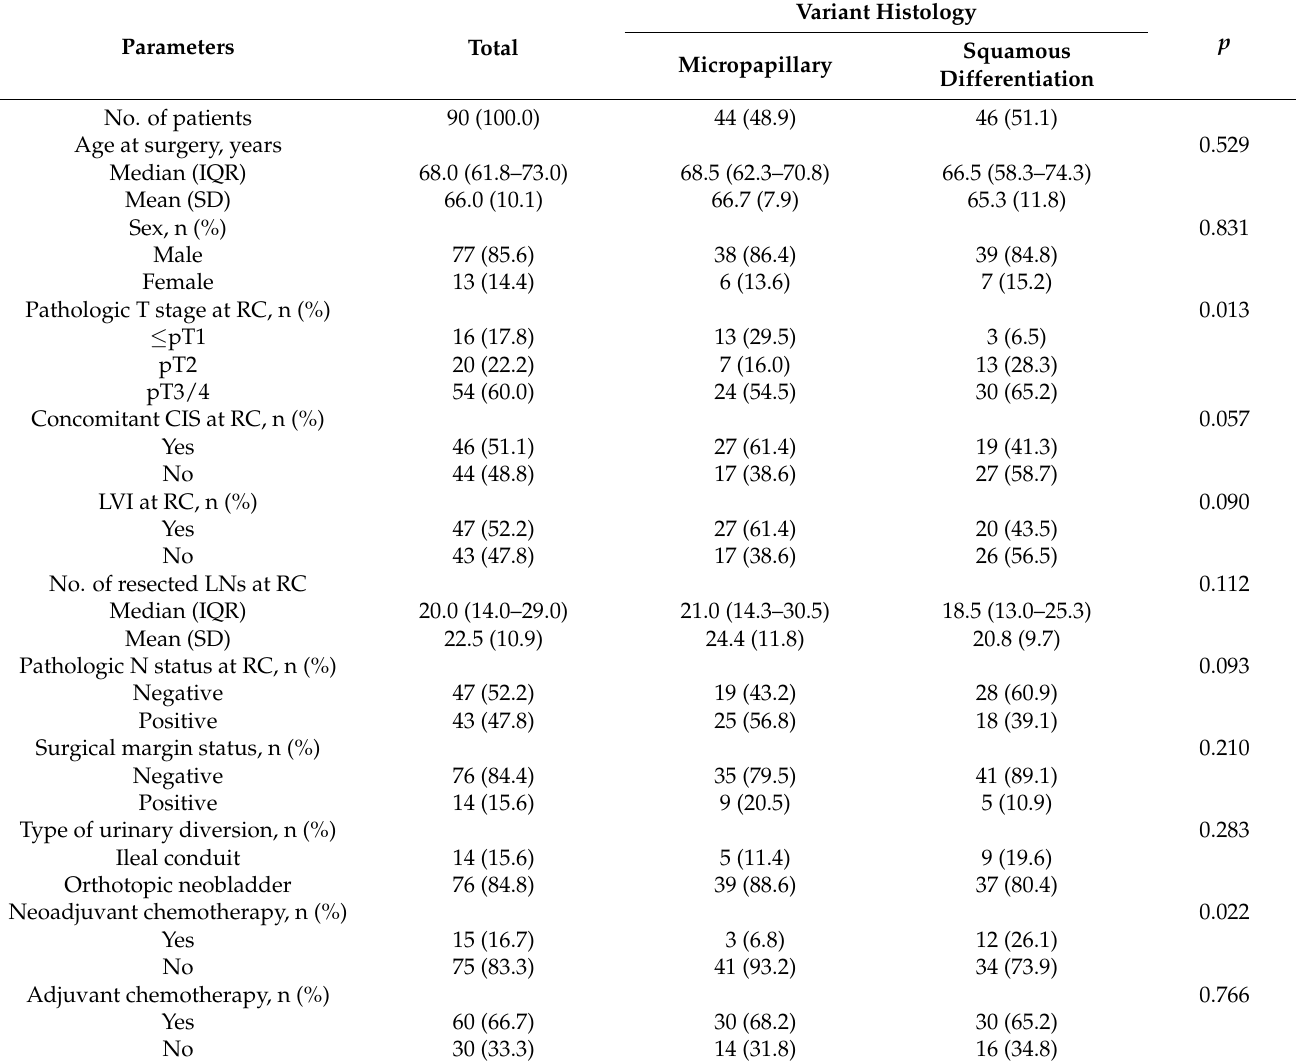
Table 1. Baseline characteristics of 90 patients with urothelial carcinoma with variant histology.